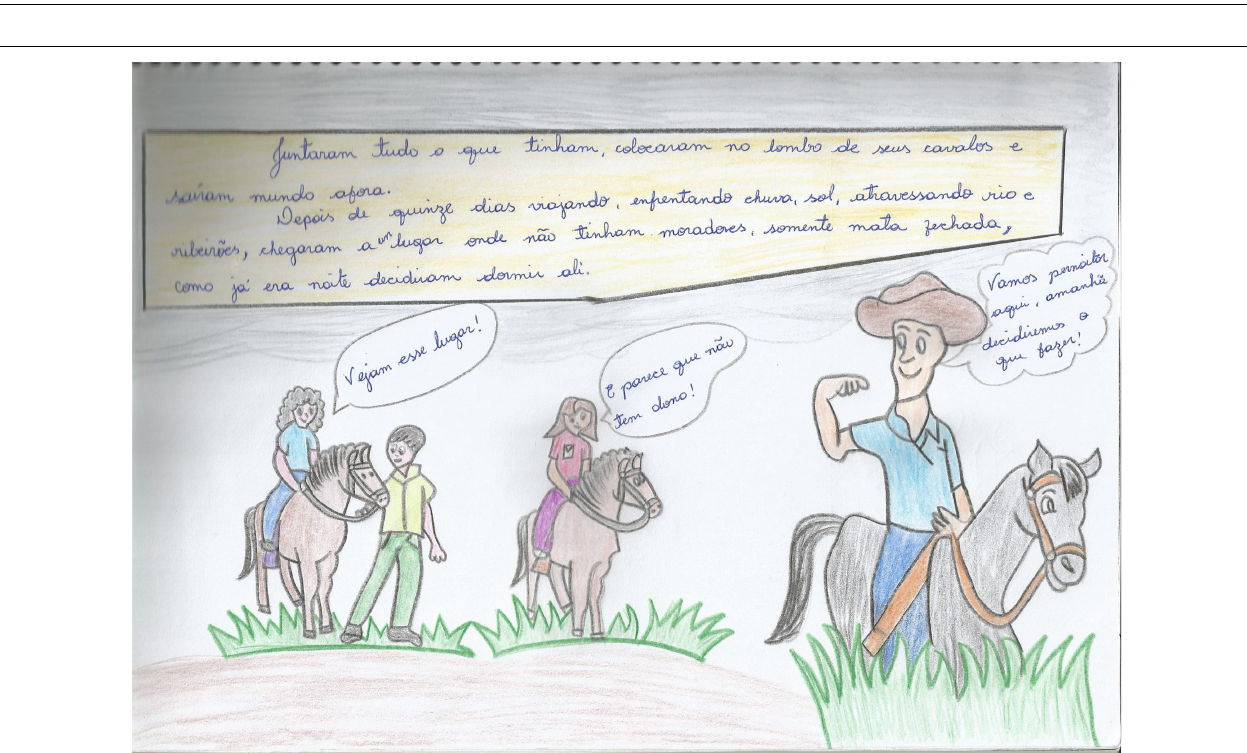
FIGURE 1 | Excerpt from a comic produced by student S1 (source: Elaborated by student S1).